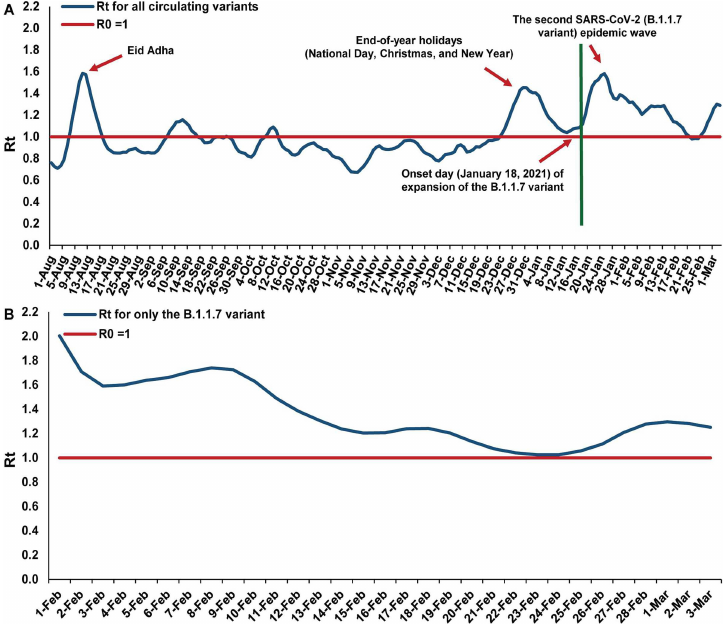
Fig 2. Estimated effective reproduction number ( R t ) for SARS-CoV-2 infection. (A) All circulating variants. (B) Only B.1.1.7. R t was calculated using the Robert Koch Institute method